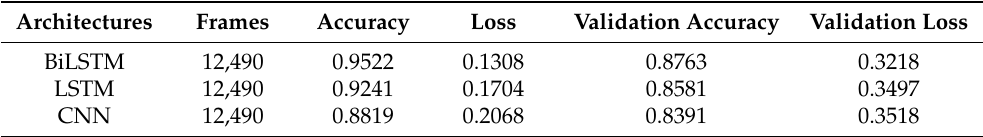
Figure 7. Train Accuracy/Loss of the BiLSTM. ( a ) BiLSTM Training Accuracy. ( b ) BiLSTM Validation Accuracy. Table 2. The Accuracy Differences Between